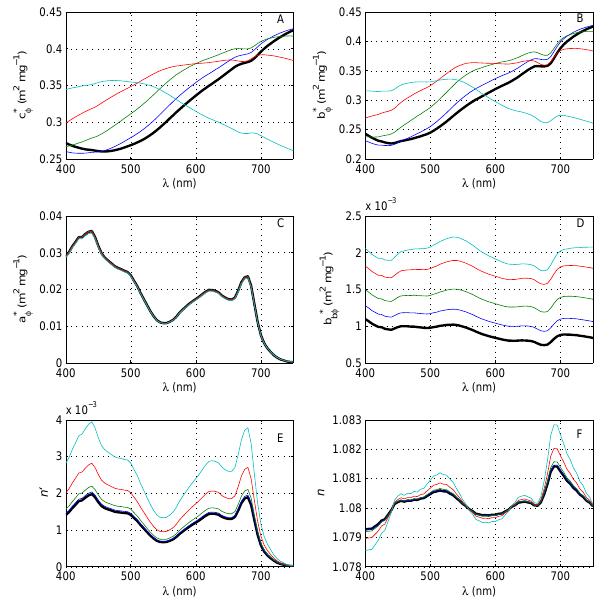
Fig. 4. Chl a -specific volume coefficients for a population of M. aeruginosa modelled as two-layered spheres with variable gas vac- uolation (A–D) . Legend same as Fig. 2. The influence of gas vac- uolation on the n 0 and n of the shell layer are also shown (E, F) . neous sphere model produced poor comparisons with mea- surements of both vacuolate and non-vacuolate cells. The flattening towards forward angle was only reproduced with a cell of significantly reduced n = 0.4 ( Schreurs, 1996). The influence that gas vacuoles might have on the VSF in the ex- treme forward and backward directions remains unknown for the present time. Although recently developed instruments have the capability to measure the VSF between 0.6 and 177 ◦ (e.g. Zhang et al., 2002), no such measurements on vacuolate and non-vacuolate cells appear to have yet been made. Figure 5a–d show the VSFs at four wavelengths. Three features attributable to the gas vacuole are immediately ap- parent: an enlargement between 20 and 70 ◦ , a flattening to- wards the forward direction < 45 ◦ , and a steady enhancement and flattening of the VSF in the backward direction > 90 ◦ for increasing vacuole content. The results are compared to those of Volten et al. (1998) in Fig. 5e and normalised to the San Diego Harbor VSF at 90 ◦ (Petzold, 1972). The two- layer model for a vacuolate cell containing V g = 10 % accu- rately reproduces the enhanced scattering between 20 and 70 ◦ , as well as the flattening in the forward direction < 45 ◦ observed for vacuolate cells. The fit between the modelled homogeneous cell and the measured non-vacuolate cell is also good in the forward direction (< 90 ◦ ). The enhancement in the backward direction from vacuoles is not observable in the measurements of Volten et al. (1998), and the magnitude of the measured VSF in the backward direction is substan- tially greater than that from the model. This is most